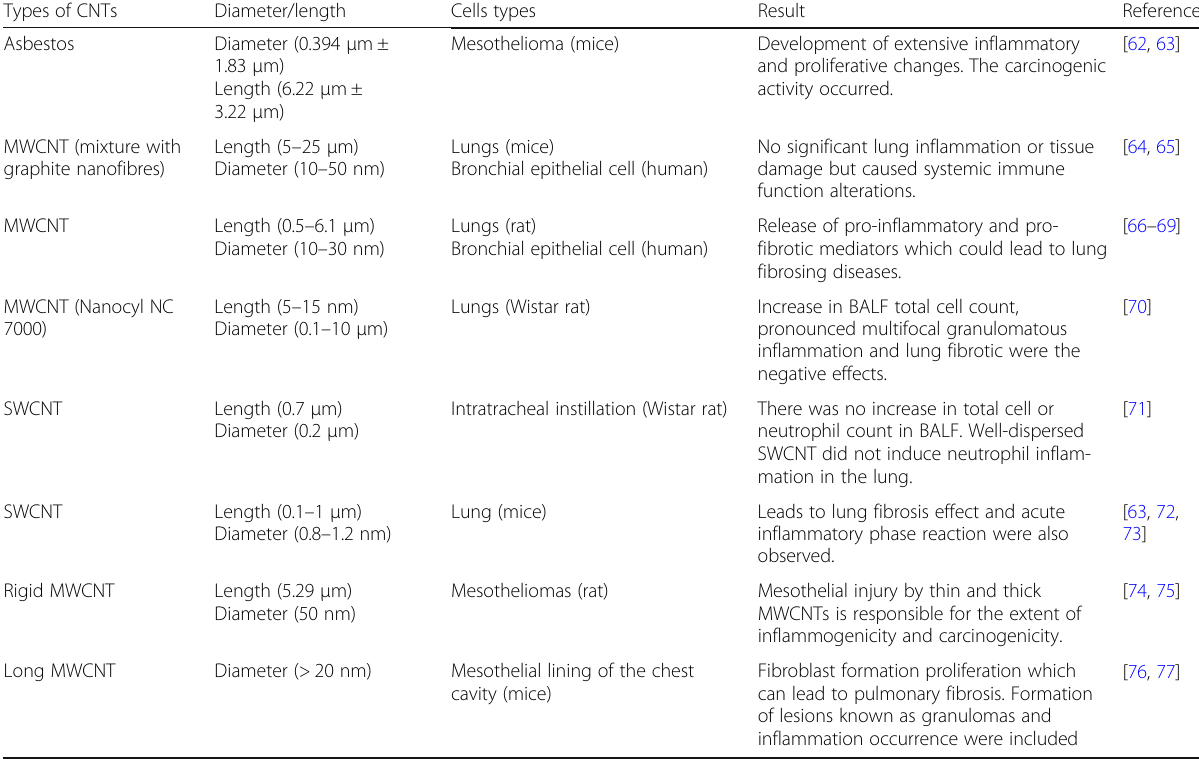
Table 1 The toxicity profiles of different types of CNTs in comparison with asbestos (in vivo